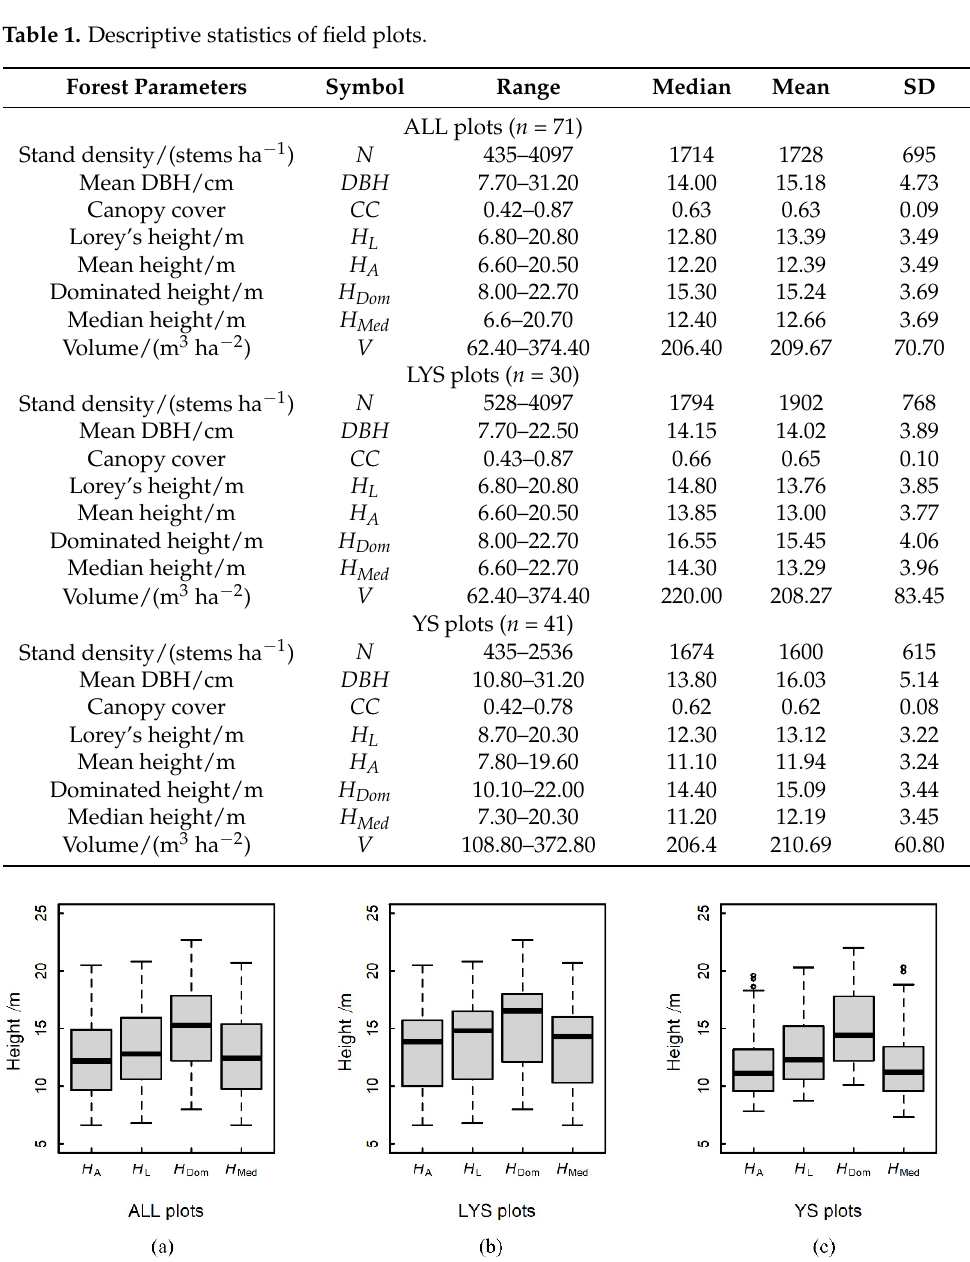
Figure 3. The boxplots of the four forest stand heights within different forest cases (ALL plots ( a ), LYS plots ( b ), YS plots ( c